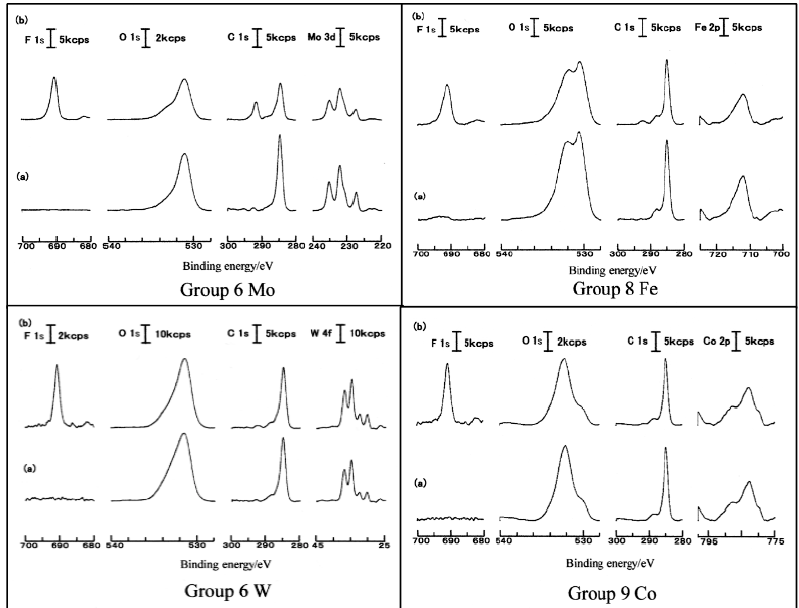
Figure 6. XPS spectra for groups 6 (Mo and W), 8 (Fe), and 9 (Co) ( a ) before and ( b ) after the TriboEE measurement.